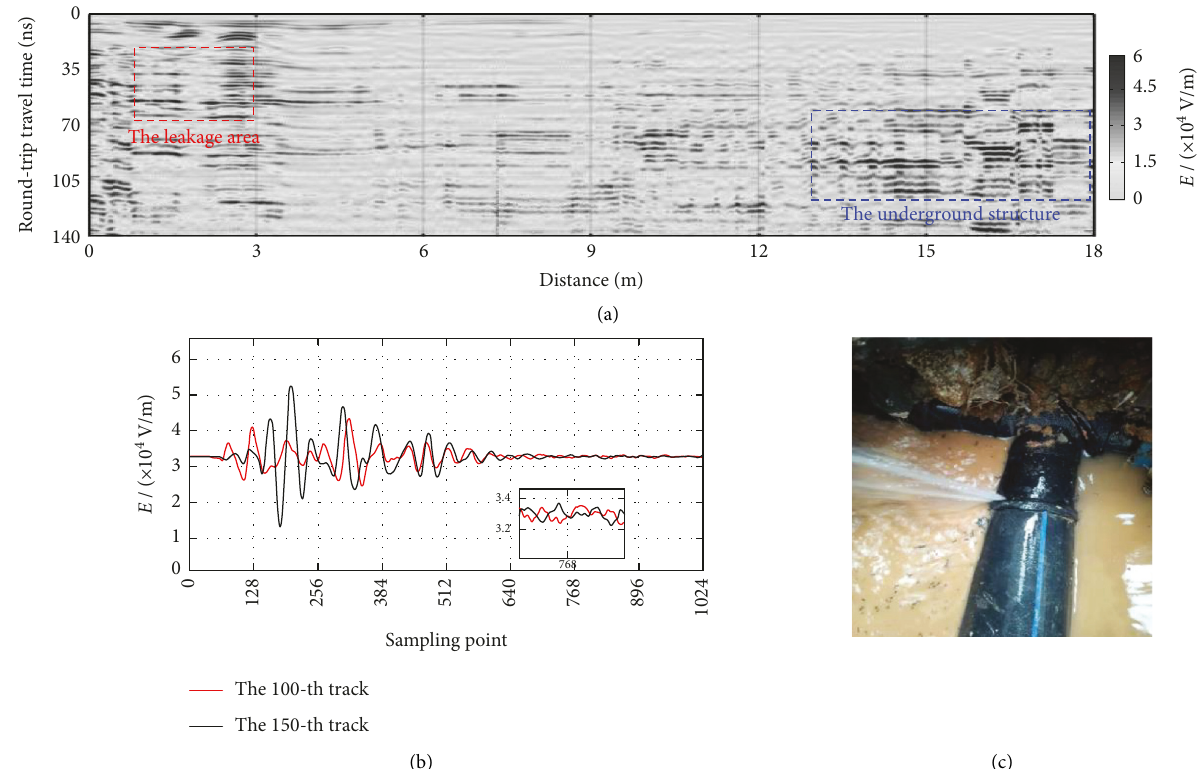
Figure 5: Detection results of the surveying line: (a) schematic diagram of electric field component interpretation, where ( E ) refers to “electric field component”; (b) schematic diagram of the comparison of electric field component for a single track; (c) photo of the leakage area at the surveying